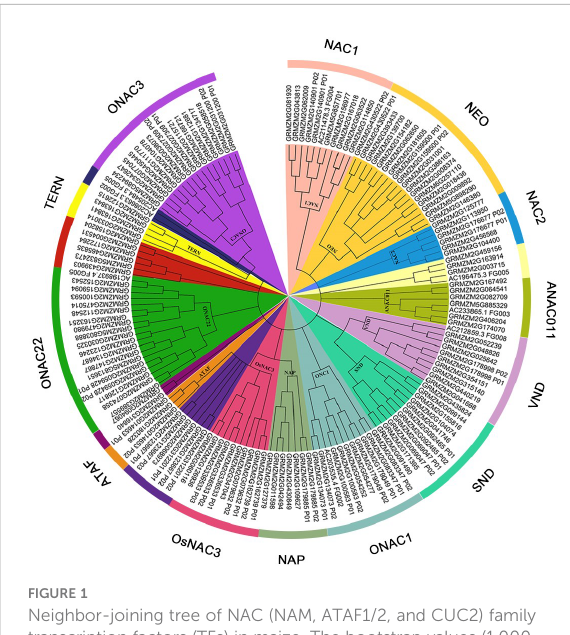
FIGURE 1 Neighbor-joining tree of NAC (NAM, ATAF1/2, and CUC2) family transcription factors (TFs) in maize. The bootstrap values (1,000 replications) are presented on the relevant